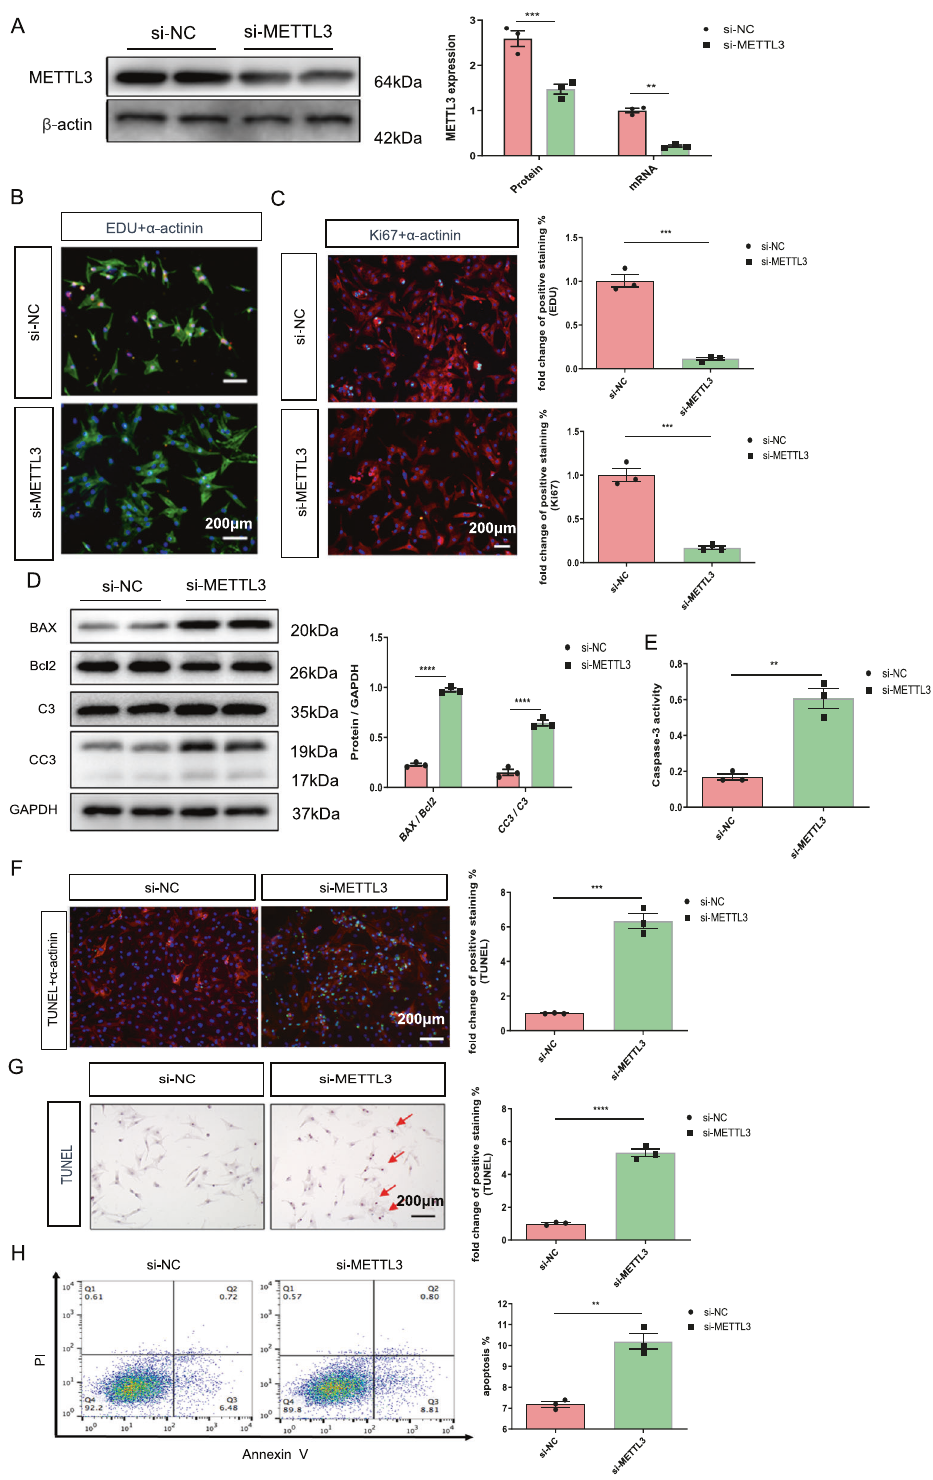
Fig. 3 METLL3 silencing mimics the effects of hypoxia on decreasing proliferative capacity and increasing apoptosis in NRCMs. A Protein and mRNA expression of METTL3 in the NRCMs from indicated groups. B Representative immuno fl uorescence images of NRCMs labeled with EDU or α -actinin (EDU, red; α -actinin, green; DAPI, blue. Scale bars, 200 μ m). C Representative immuno fl uorescence images of NRCMs labeled with Ki67 or α -actinin ( α -actinin, red; Ki67, green; DAPI, blue. Scale bars, 200 μ m). D Protein level of BAX, Bcl2, C3, and CC3 in the NRCMs. E Caspase 3 activities of NRCMs from indicated groups. F , G Representative immuno fl uorescence ( F ) and immunohistochemical ( G ) staining images of NRCMs labeled with TUNEL ( α -actinin, red; TUNEL, green; DAPI, blue. Scale bars, 200 μ m), and the corresponding quantitative analysis. H The results of fl ow cytometry on apoptosis in NRCMs. N = 3. The data were presented as the mean ±